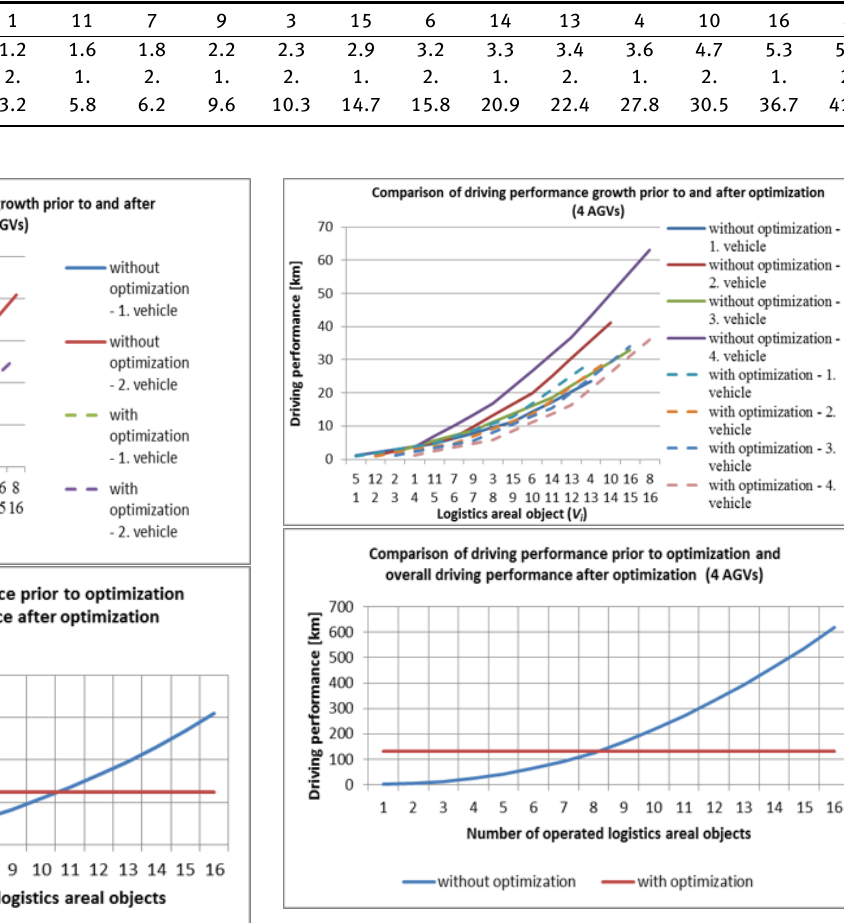
Figure 4: Course of driving performance prior to and after the dis- tance optimization when using four AGVs 8) and the overall driving performance to operate individ- ual buildings ( Vi ) is ∑︀ n dp = 250.1 km (veh. 1 = 119.6 i i =1